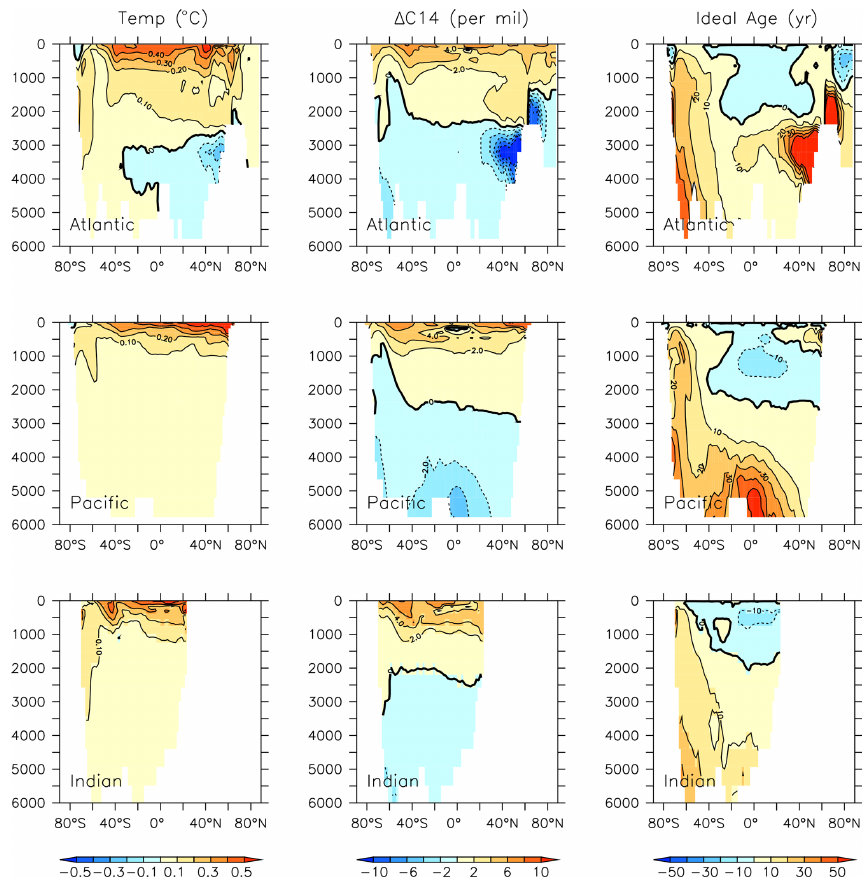
Figure 20. Modelled change in temperature, radiocarbon and ideal age profiles by major ocean basins from 1964 to 2014.